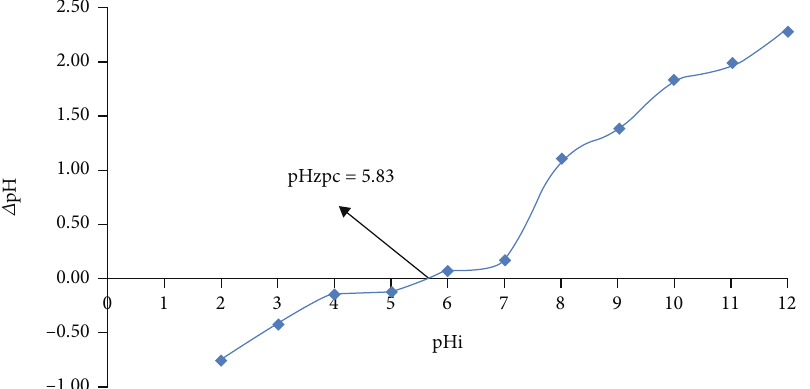
Figure 3: Point of zero charge for phenol adsorption onto TMCC.